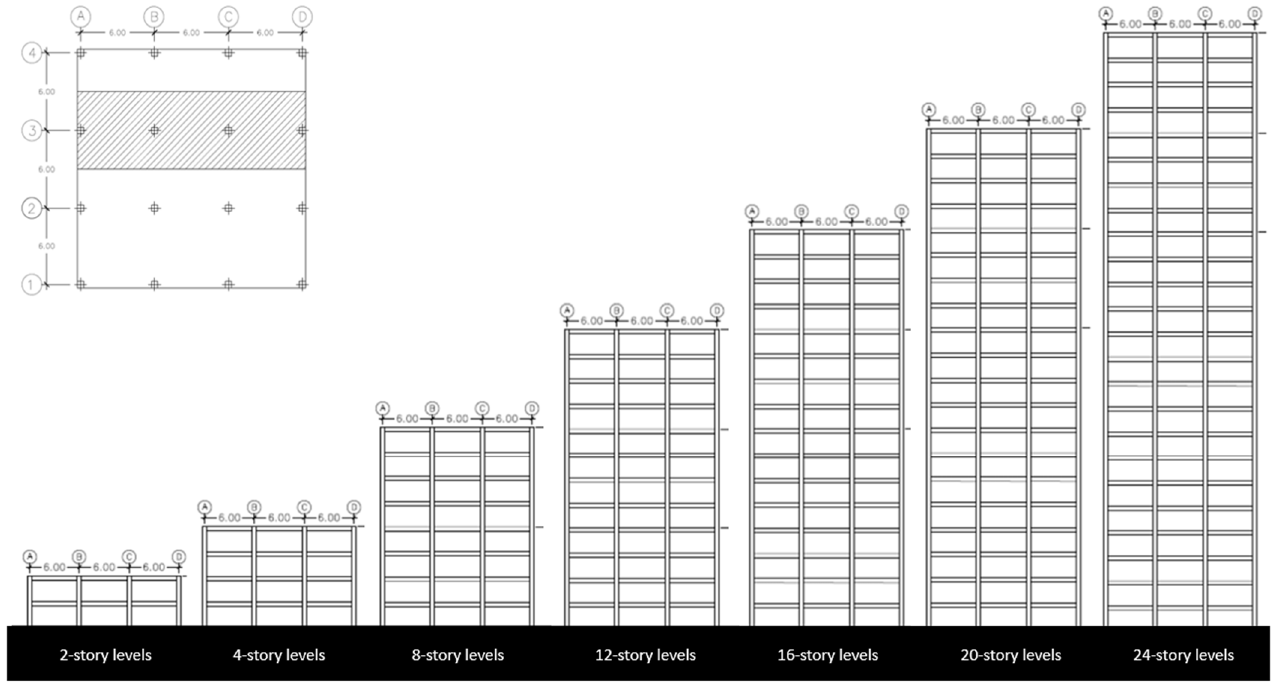
Figure 2. Schematic view of the plane frame models studied.